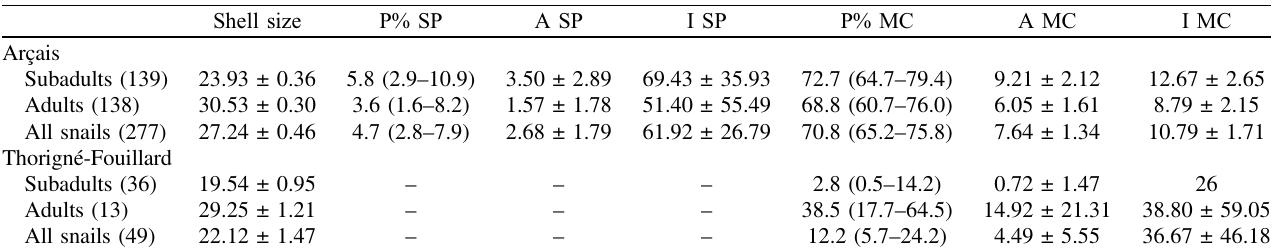
Table 3. Occurrence of Brachylaima sporocysts (SP) and metacercariae (MC) in C. aspersum from Arçais and Thorigné-Fouillard.